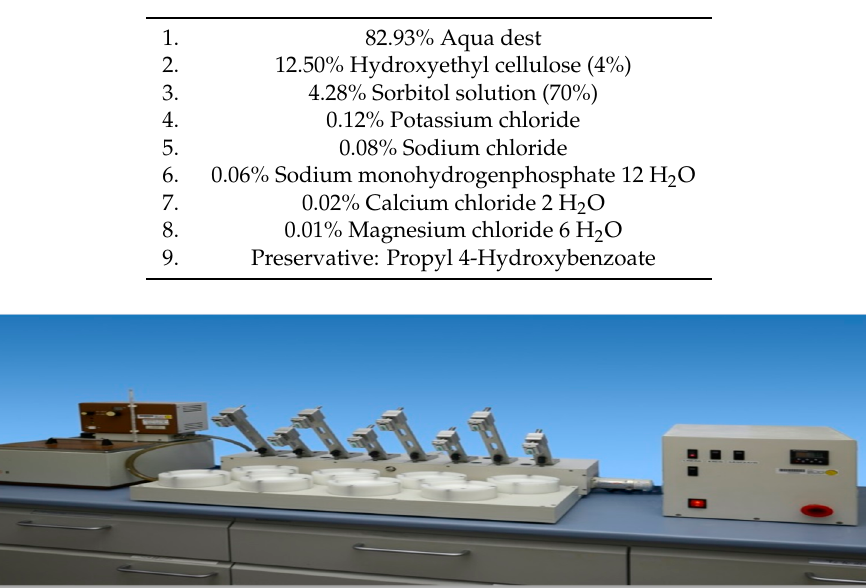
Table 2. Composition of artificial saliva.